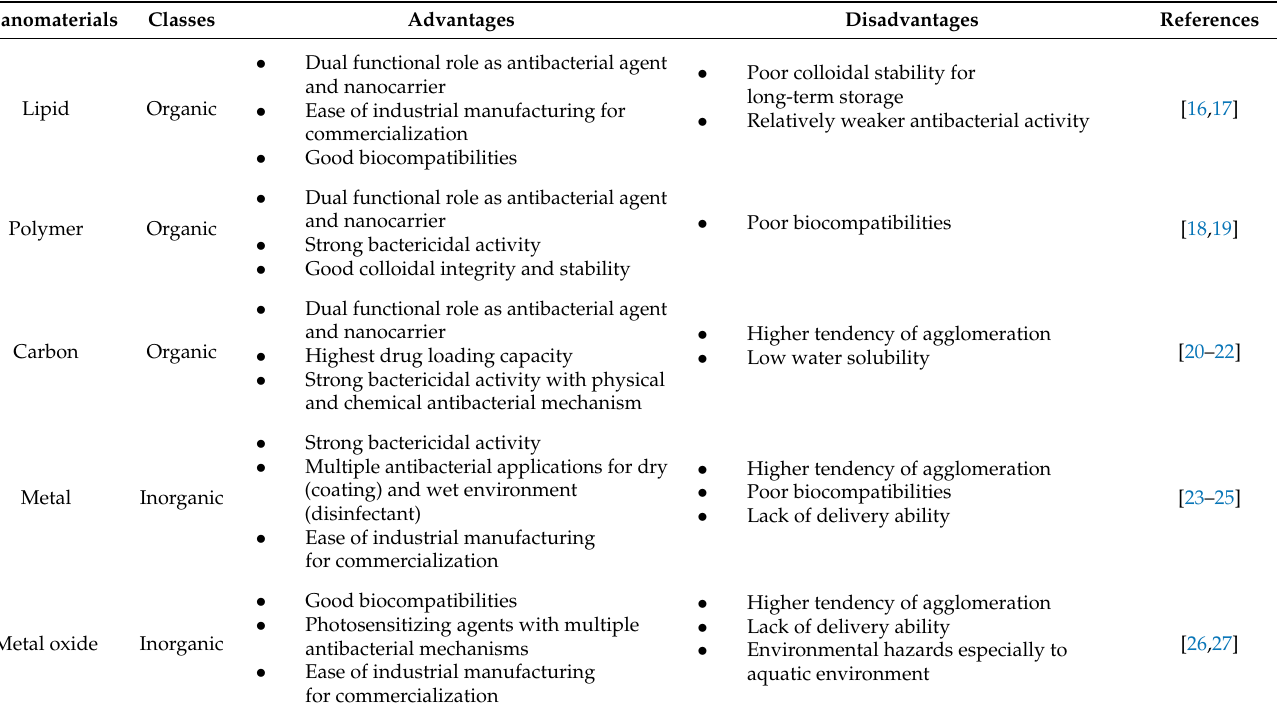
Table 1. Summary table of the